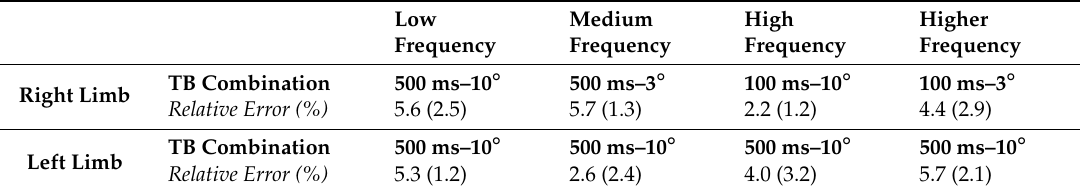
Table 1. The best-performing combination for all the examined industrial case studies with related mean value and standard deviation of the relative error. TB combination stands for the time (ms) and the amplitude ( ◦ ) threshold value set for reaching the lowest relative